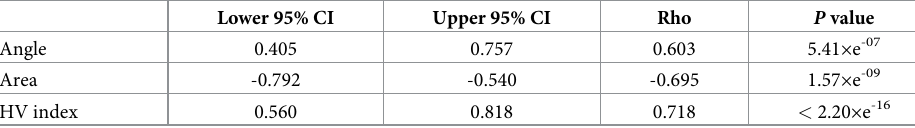
Table 1. Difference in Spearman’s Rho values by measuring methods.